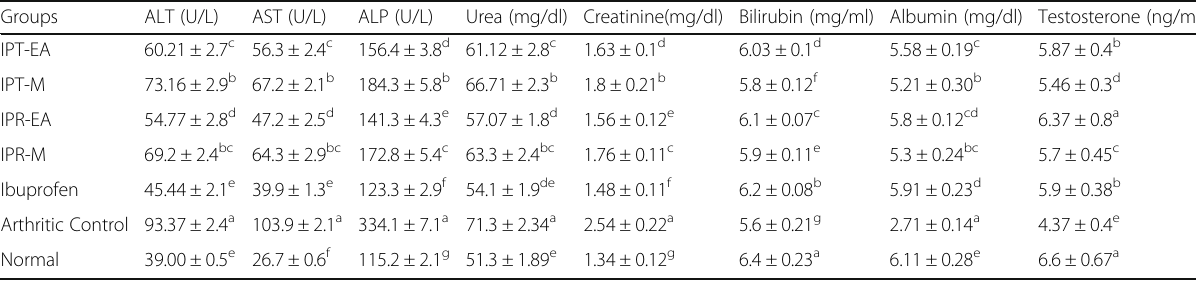
Table 8 Enzymatic and biochemical investigation of control and arthritic rats Groups